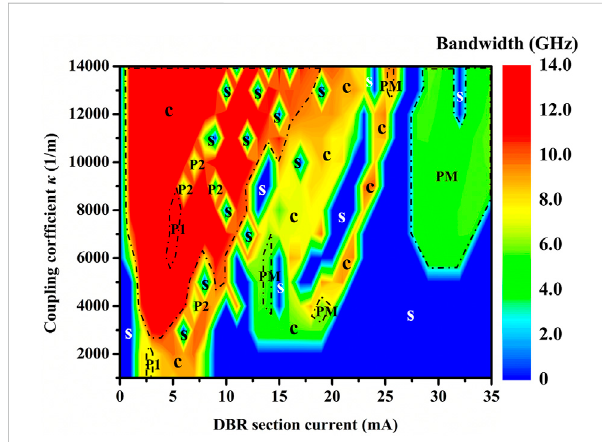
FIGURE 9 Map of bandwidth and dynamic states in the parameter space of I DBR and the DBR grating coupling coef I Phase = 16.0 mA. S, P1, P2, PM, and C correspond to steady state, single-period oscillation, doubling period oscillation, multi- period oscillation, and chaos,